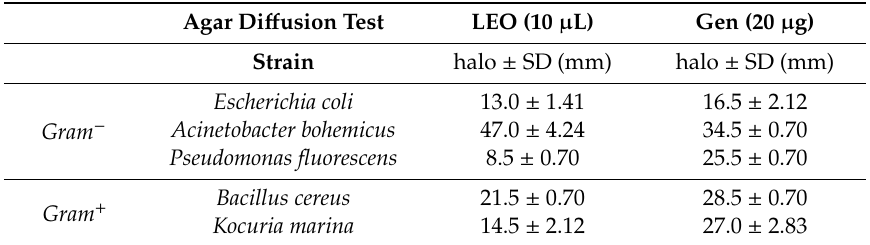
Table 3. Growth inhibition halo (mm) for LEO and the positive control (gentamicin) against the five tested Gram + and Gram − bacterial strains ( p values ≤ 0.05).